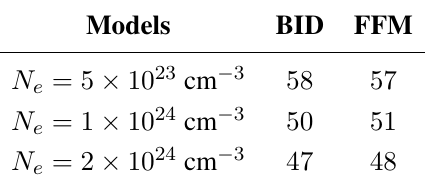
Table 2. Dynamics-to-static relative dip ( % ) measured on the argon He- (cid:12) line for T = 1